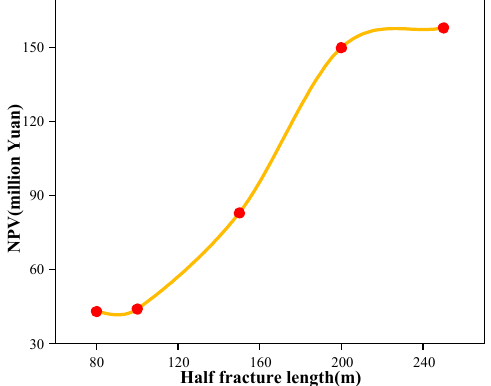
Figure 13. Diagram of NPV variation with half fracture length.